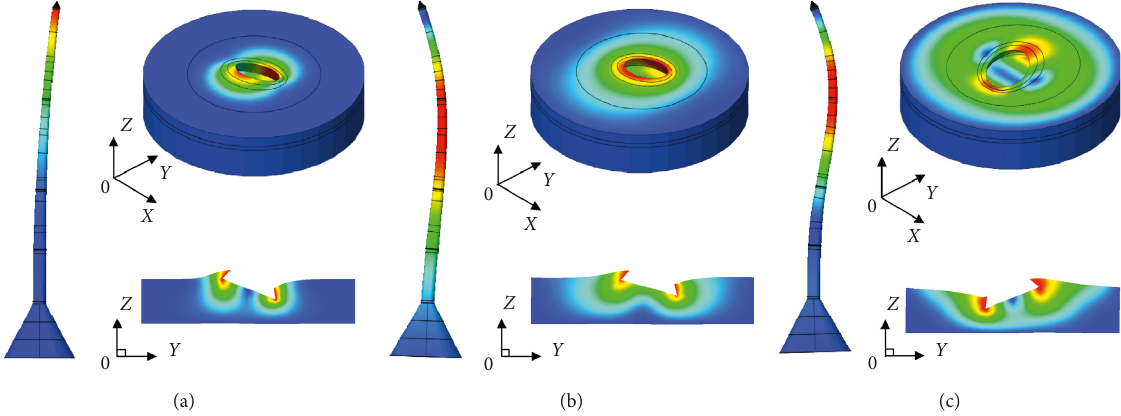
Figure 4: Across-wave directional bending modes from eigenvalue analysis. (a) Mode By1 (0.2840Hz). (b) Mode By2 (1.5897Hz). (c) Mode By3 (2.4576 Hz).